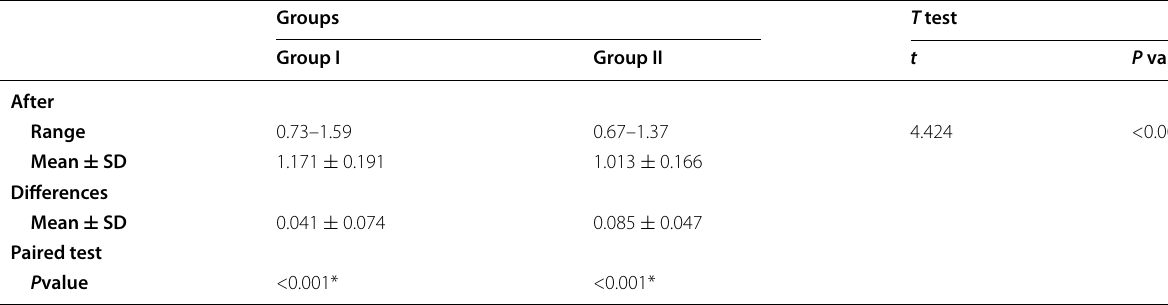
Table 3 Comparison between each group before and after treatment and the two studied groups according to total cholesterol level